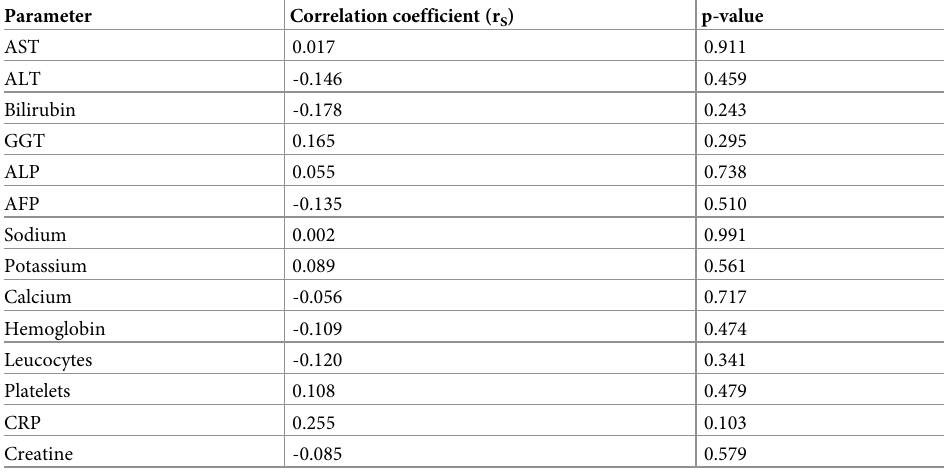
Table 3. Correlation analysis between miR-107 expression levels and various laboratory markers.